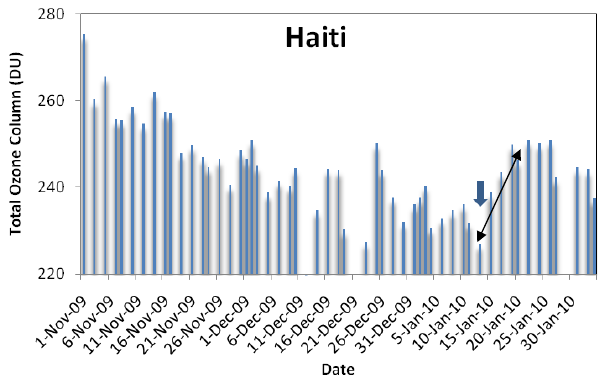
Fig. 5. Figure 5 shows variation of total ozone column (TOC), a drop in TOC is observed on the day of earthquake i.e. 12 January Figure 5. shows variation of total ozone column (TOC), a drop in TOC is observed on the 2010, afterwards the TOC is found to be day of earthquake i.e. 12 January 2010, afterwards the TOC is found to be stable.